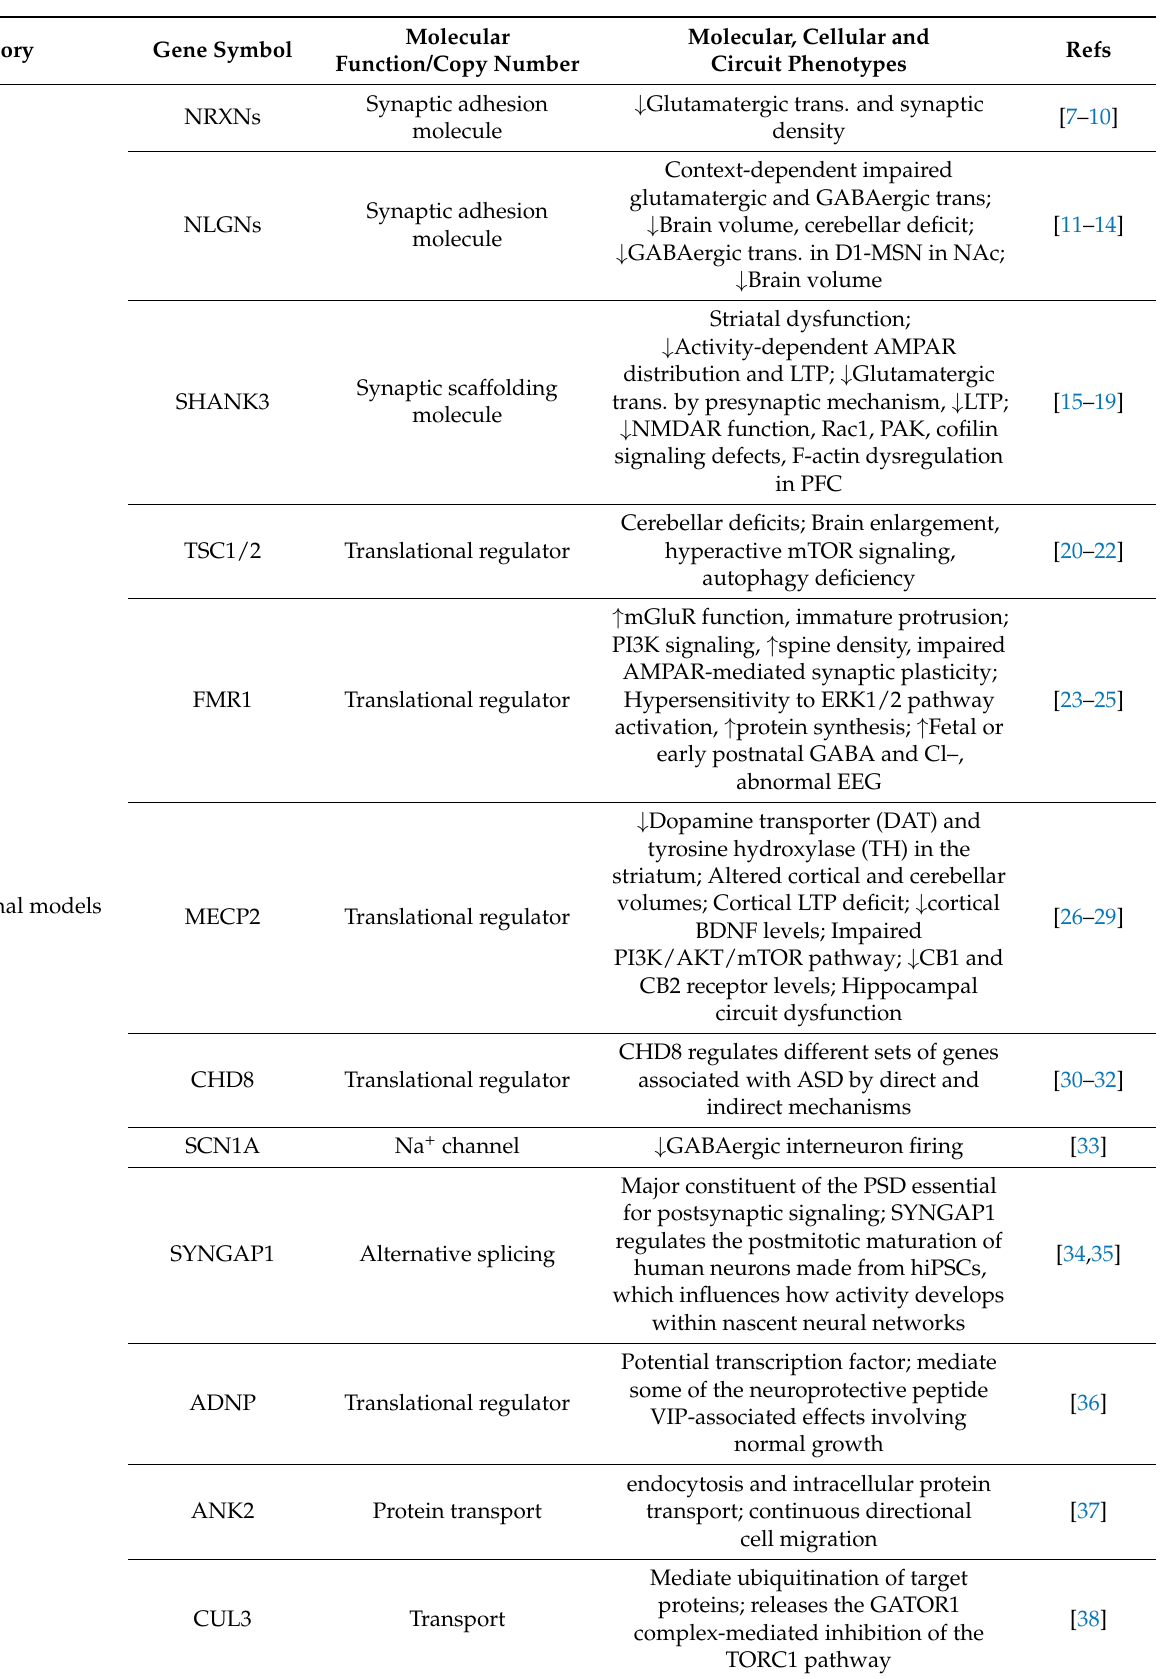
Table 1. Mouse models of